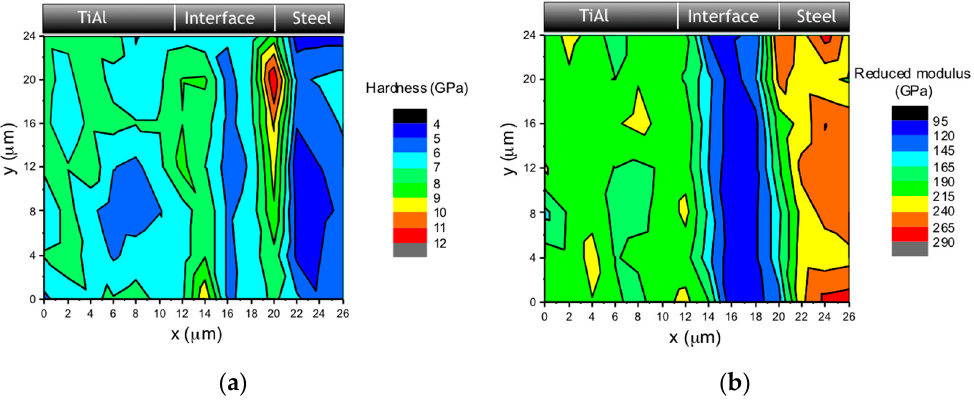
Figure 5. ( a ) TEM image of the zone close to the steel; ( b ) TEM images and SAED indexation as α‐ Fe of a grain at the region marked as 1 in ( a ); and ( c ) HRTEM images and FFT indexation as Fe 2 Ti of a grain at the region marked as 2 in ( a ).